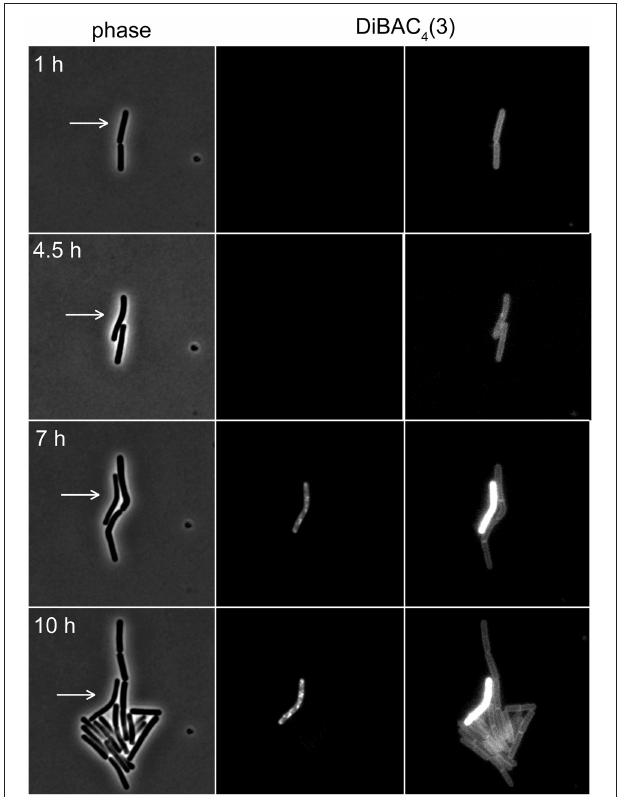
FIGURE 7 | Time-lapse microscopy using voltage sensitive dye DiBAC 4 (3). Selected images of a time-lapse microscopy experiment carried out with B. subtilis cells stained with DiBAC 4 (3). Phase contrast images (left panel) and DiBAC 4 (3) fluorescence images (right panels) are depicted. Due to the strong fluorescence intensity difference between polarized and depolarized cells, the images are shown with two different contrast settings. High fluorescence intensity of DiBAC 4 (3) indicates low membrane potential. An individual cell that failed to enter logarithmic growth and subsequently undergoes membrane depolarization, is indicated with an arrow. See Supplementary Movie 1 for an example of a whole time-lapse series. Strain used: B. subtilis 168 (wild type).